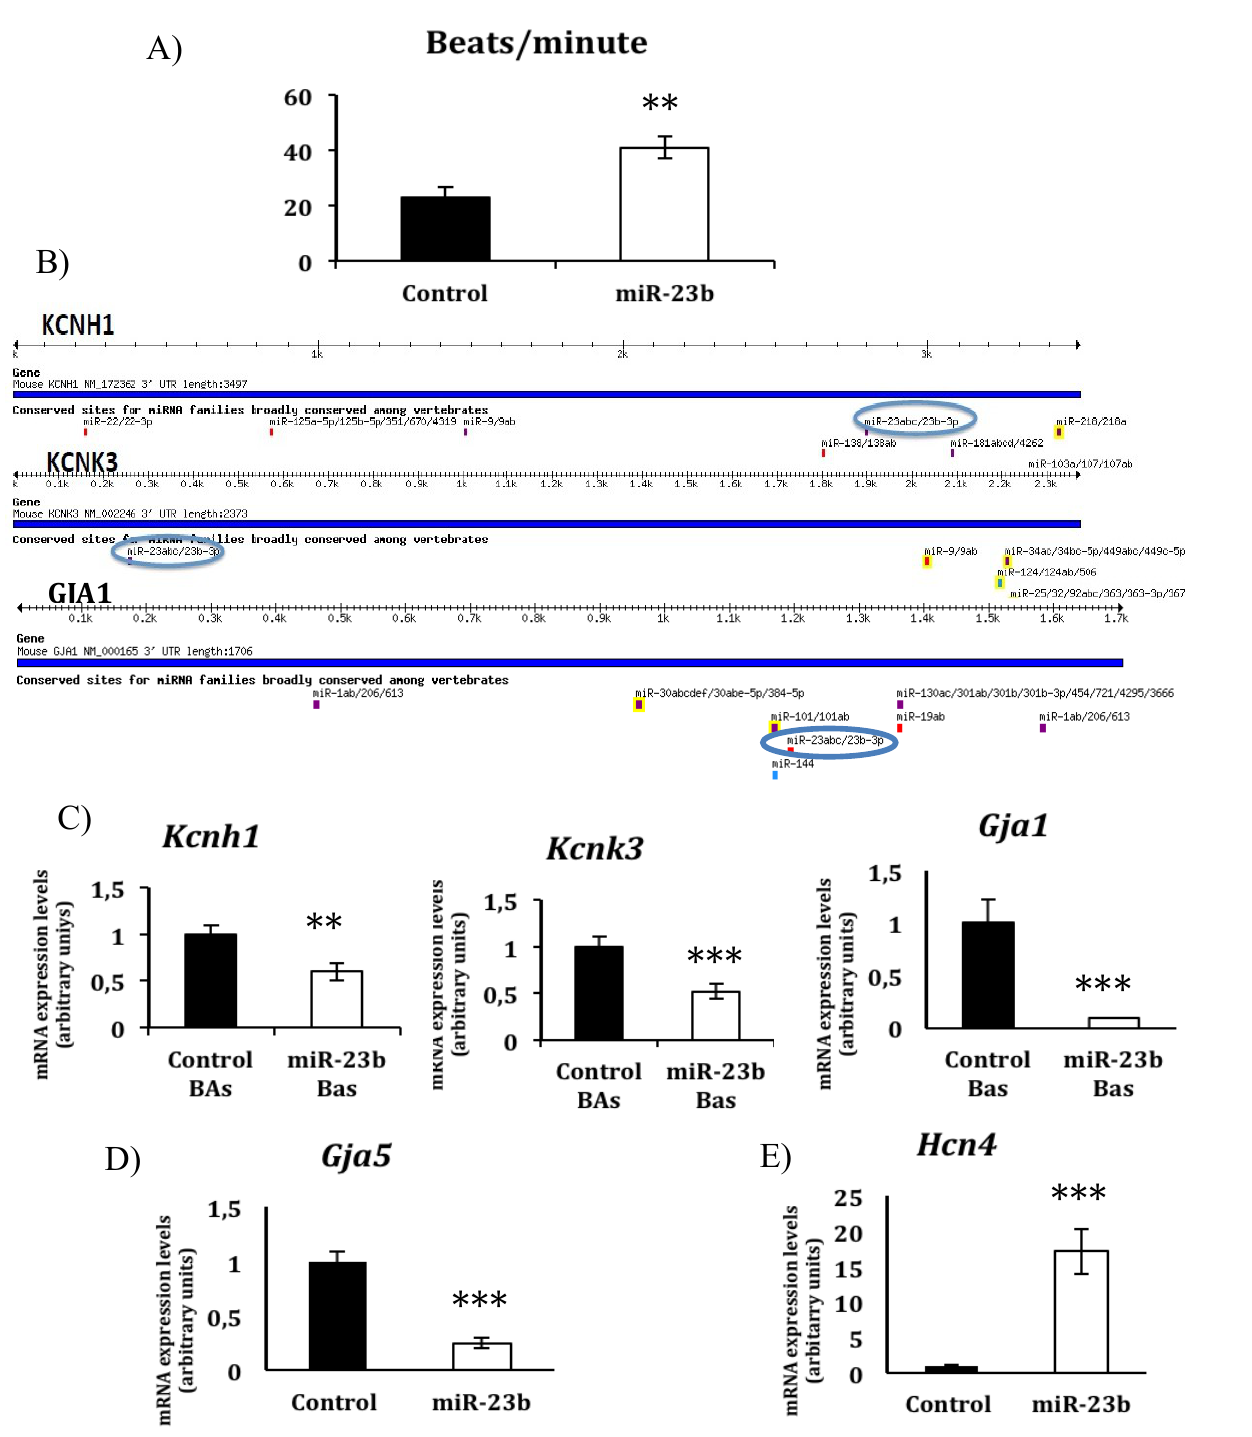
Figure 3. ( A ) Quantification of the number of beats per minute in beating areas from EBs overexpressing miR-23b (n = 15) in comparison with beating areas derived from EBs control (n = 13). ( B ) Schematic representation of the putative microRNA binding sites in Hcnh1 and Kcnk3 3'-UTR regions as revealed by TargetScan algorithm (www.targetscan.org). ( C ) Hcnh1 , Kcnk3 and Gja1 expression profiles on EBs overexpressing miR-27b. ( D ) Gja5 expression profile on EBs overexpressing miR-27b. ( E ) Hcn4 expression profile on EBs overexpressing